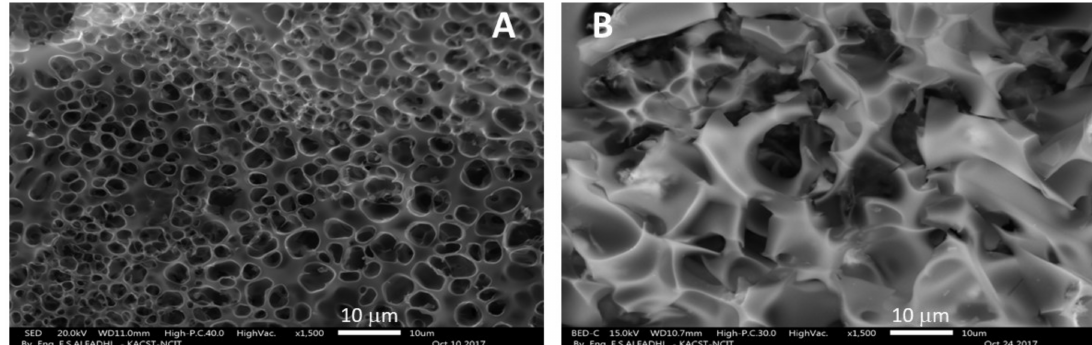
Figure 5. SEM micrograms obtained for N-GOs ( A ) PPy/Ar-1 ( B ) PPy/Ar-2.